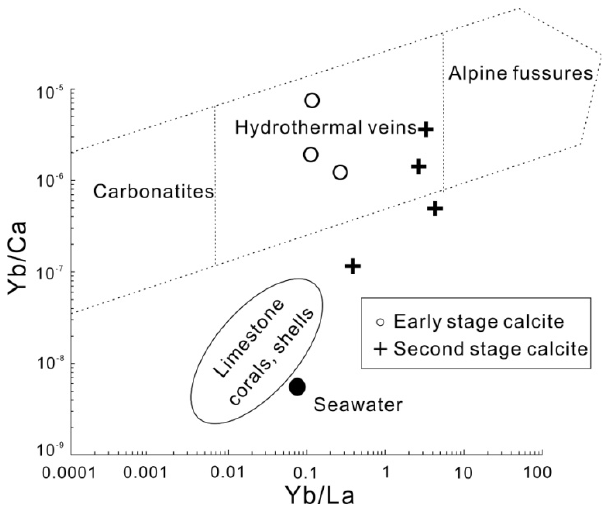
Figure 9. Plot of Yb/La vs. Yb/Ca in calcite. The areas of different types of calcite are from reference [48].